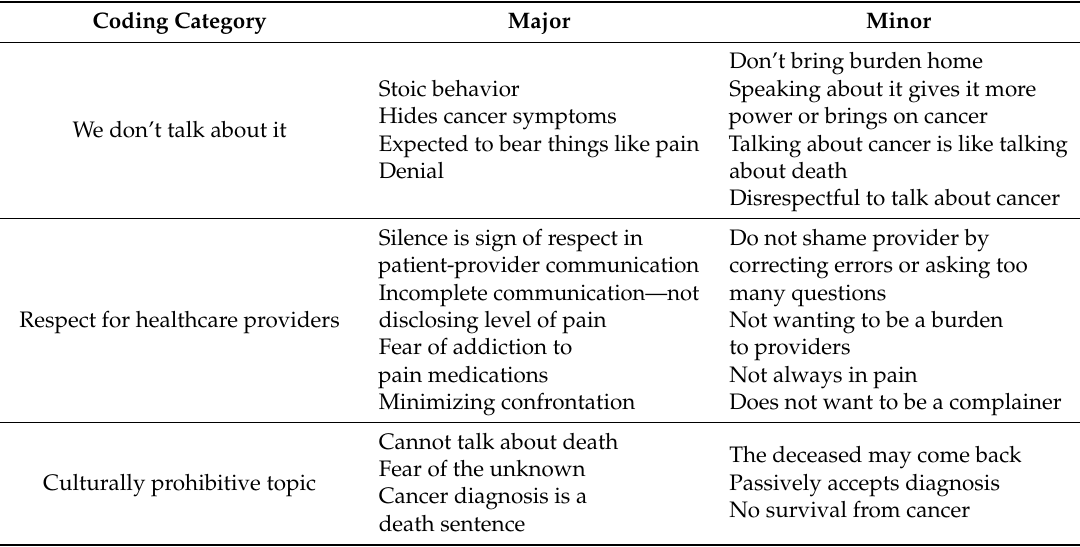
Table 1. Description of coding, identification of major and minor focus group